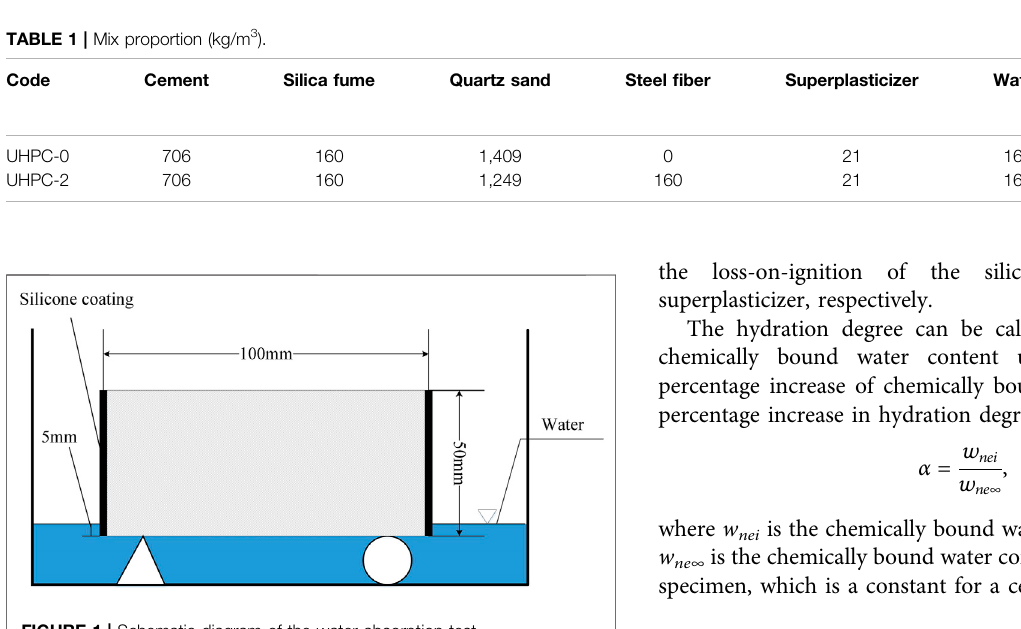
FIGURE 1 | Schematic diagram of the water absorption